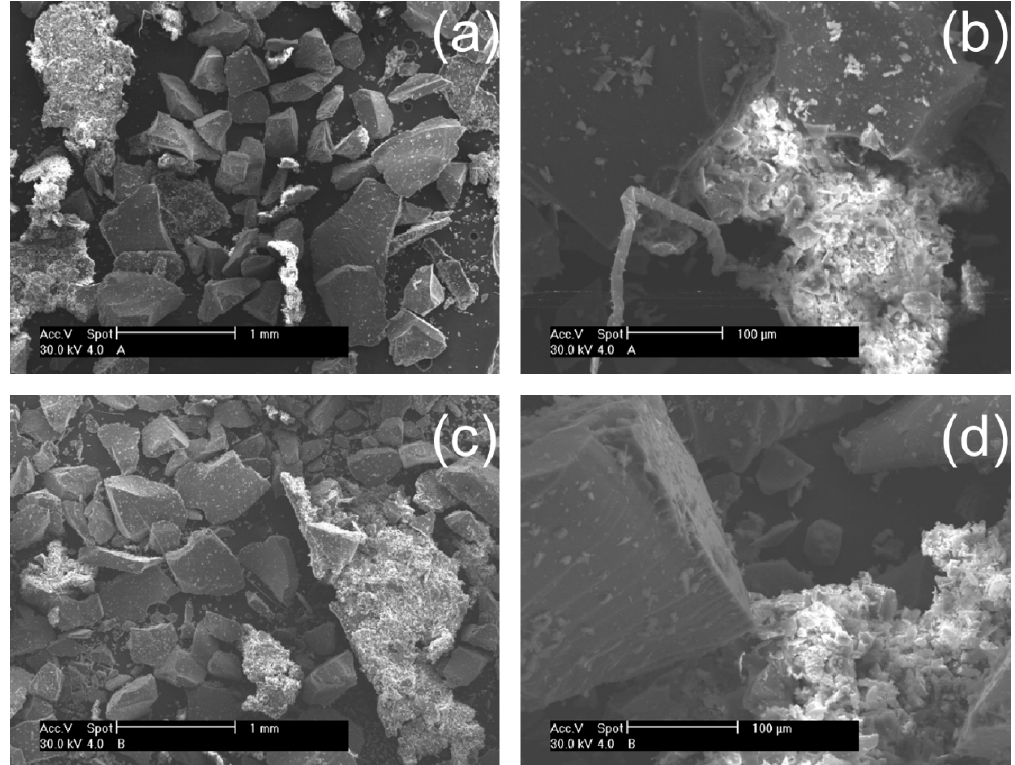
Figure 4. Scanning electron microscopy (SEM) images of ( a ) and ( b ) LCD waste before the treatment and ( c ) and ( d ) after cross-current acid leaching. SEM was equipped with EDS EDAX detecting unit. Samples were milled to homogenize the composition, and they were made conductive with a thin layer of graphite.